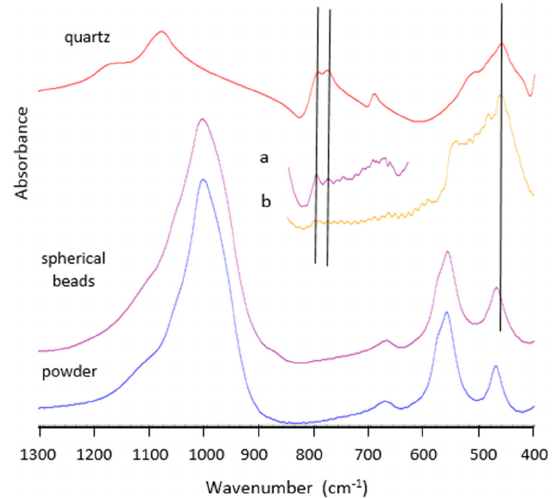
Figure 8. Transmission FTIR spectra of powder and powdered spherical beads for 4A zeolite samples (low concentration samples) and results of spectral subtractions ( a ) (high concentration samples) and ( b ) (low concentration samples) and comparison with quartz (HR Minerals library).